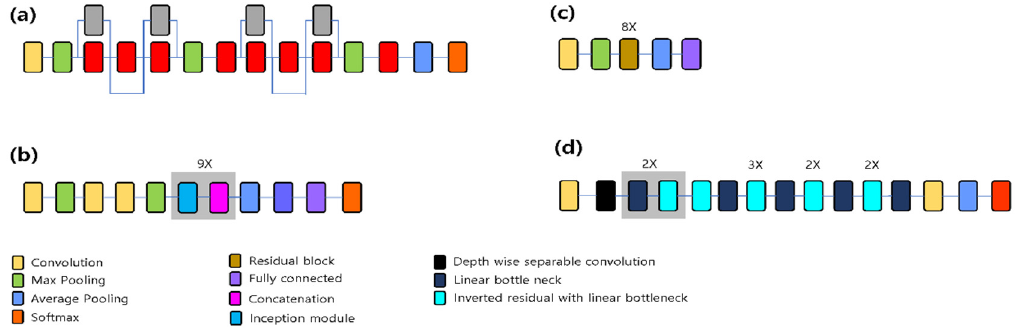
Figure 3. Pretrained network architectures. ( a ) SqueezeNet, ( b ) GoogLeNet, ( c ) ResNet-18, and ( d ) MobileNet-v2. In ResNet-50, each 2-layer residual block of ResNet-18 is replaced in the 34-layer net with the 3-layer bottleneck